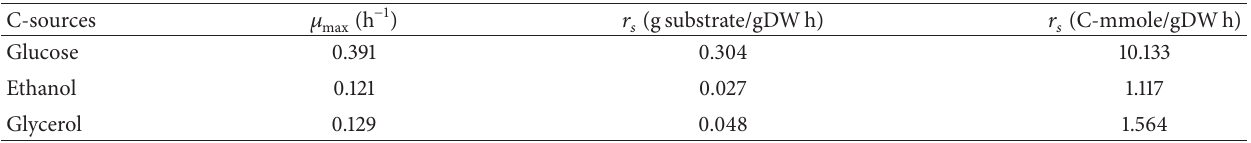
Table 2: Specific rates for the 3 sets of